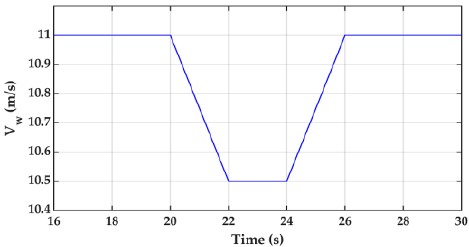
Figure 11. Variation of wind speed.